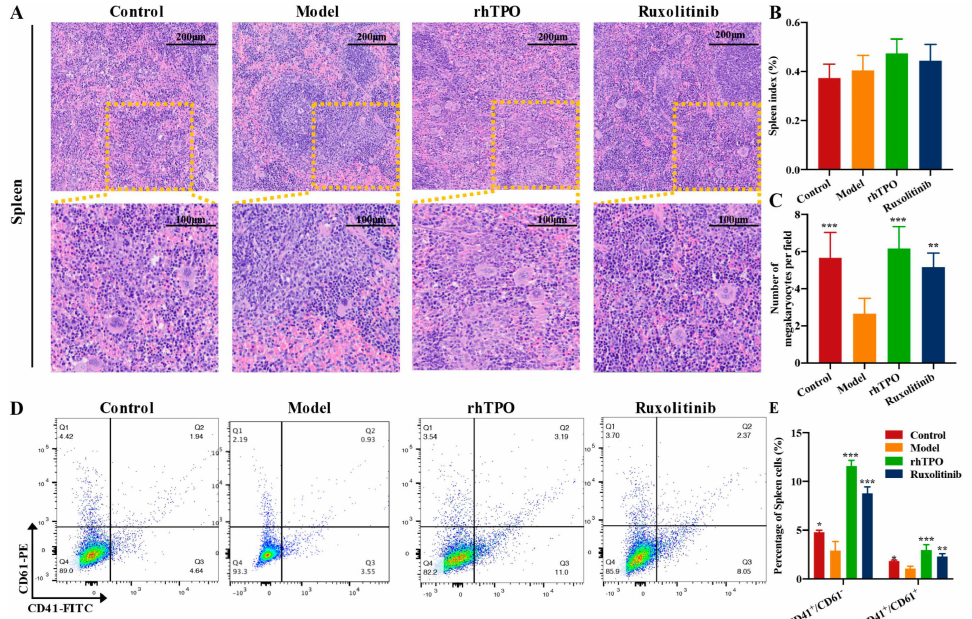
Figure 5. Ruxolitinib restores splenic hematopoiesis. ( A ) Images of H&E staining of spleen taken with a microscope at magnifications of 100 × (top) and 200 × (bottom); ( B ) Spleen‑body weight ratio (n = 6 per group); ( C ) The number of MKs in each group is indicated by the histogram; ( D ) The examination of the expression of CD41 and CD61 in each group by flow cytometry after receiving therapy for 12 days; ( E ) The histogram represents the percentage of CD41 + CD61 + cells in each groups. Data represent the mean ± SD of three independent experiments. * p < 0.05, ** p < 0.01, *** p < 0.001 vs. the model